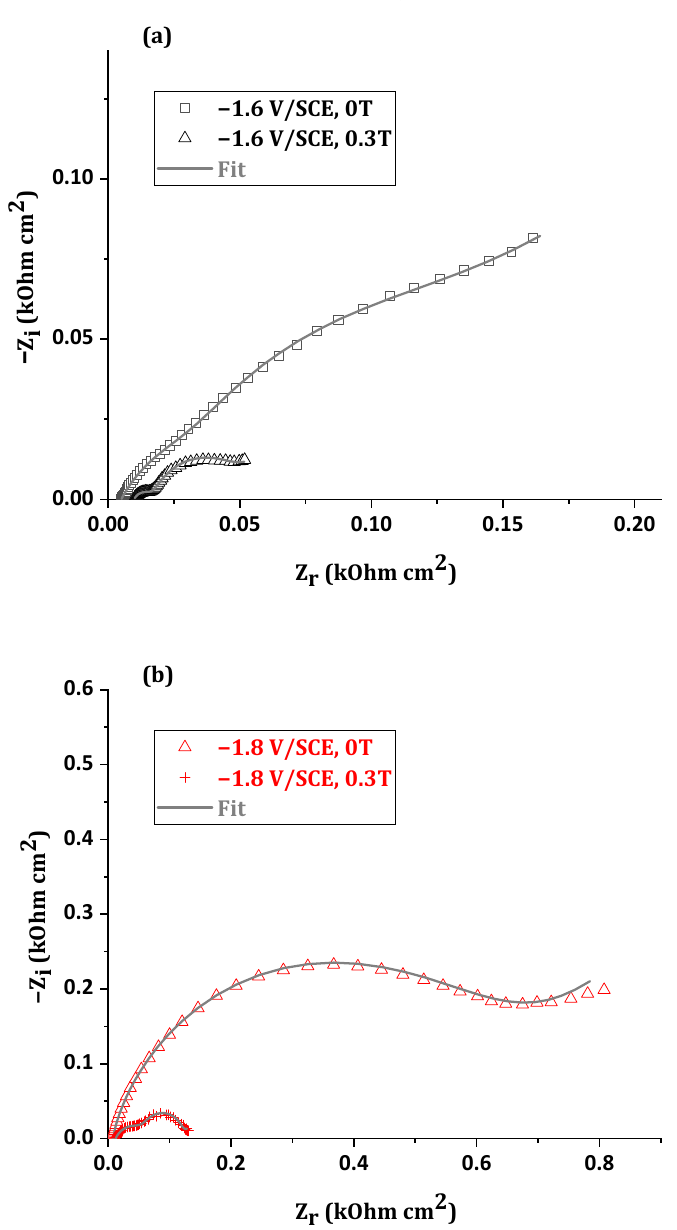
Figure 7. Nyquist plots for Zn–Mn alloy coatings electrodeposited with and without the magnetic field and for two imposed potentials ( a ) E = − 1.6 V/SCE and ( b ) E = − 1.8 V/SCE after 2 h of immersion in 3.5% NaCl solution.